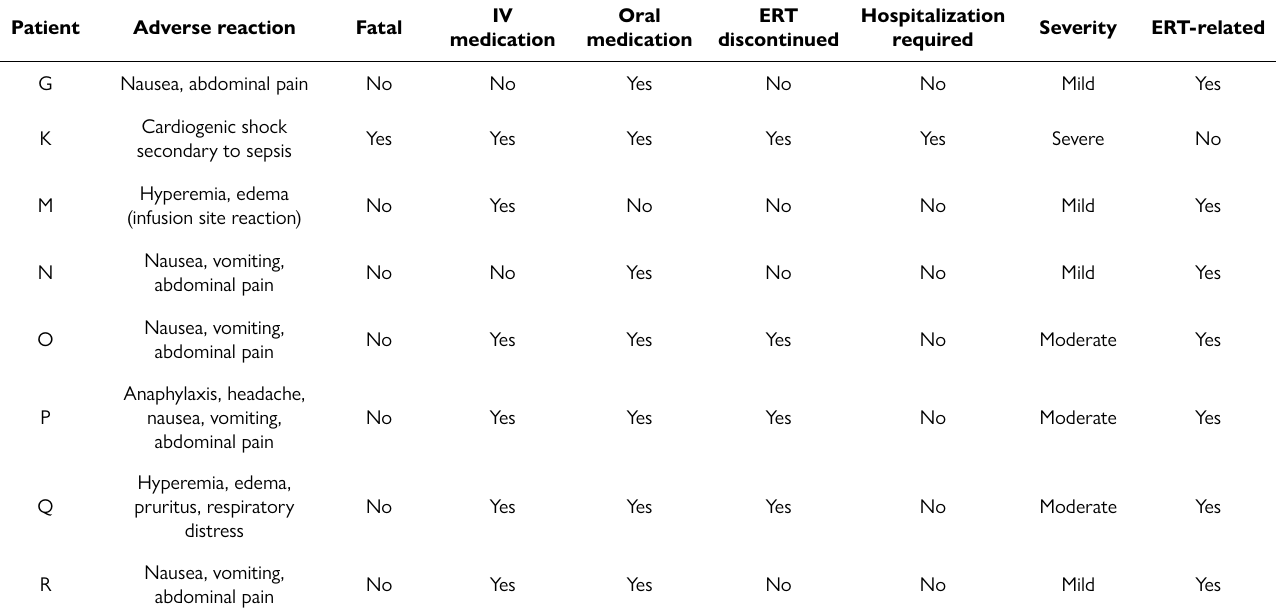
ERT, enzyme replacement